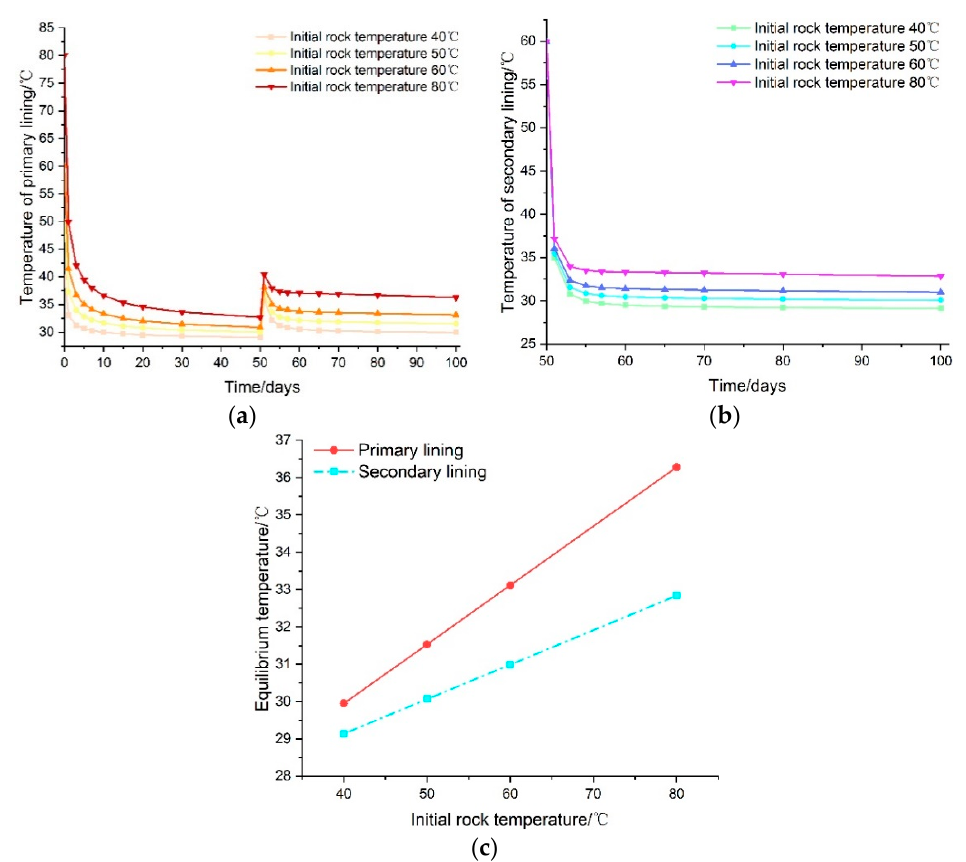
Figure 15. Temperature variation characteristics of lining structure under different conditions. (a) Temperature change of primary lining. ( b ) Temperature change of secondary lining. ( c ). Equilibrium temperature of lining structure under different initial rock temperature.